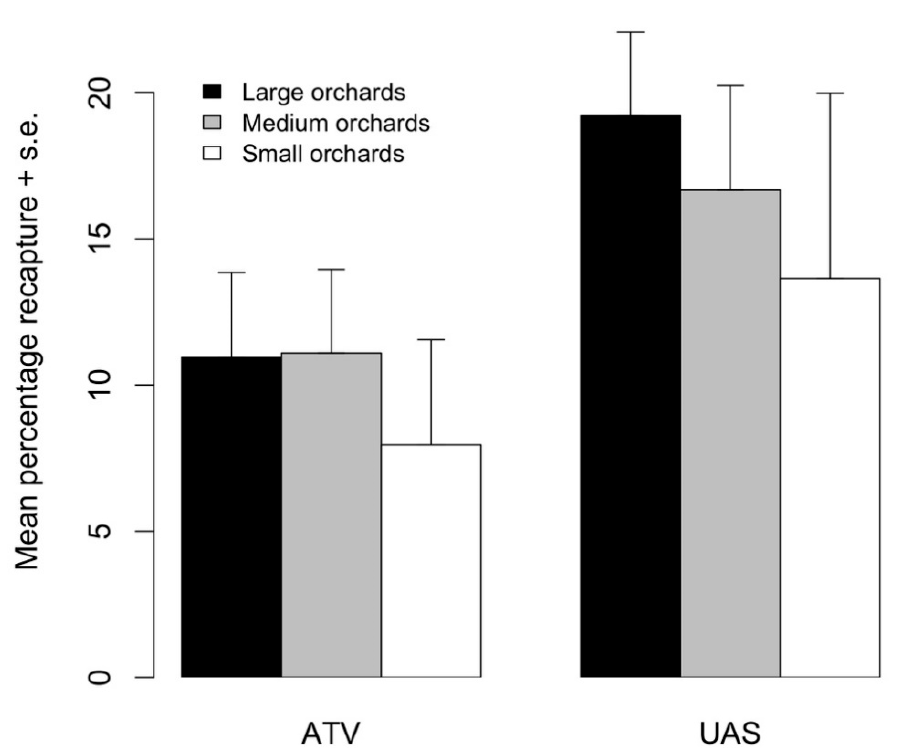
Figure 5. Mean percentage of moths recaptured in small, medium, and large orchards when released from an all-terrain vehicle (ATV) or uncrewed aerial system (UAS). Height of bars indicates the average percentage recapture (+1 standard error) from four replicated releases.